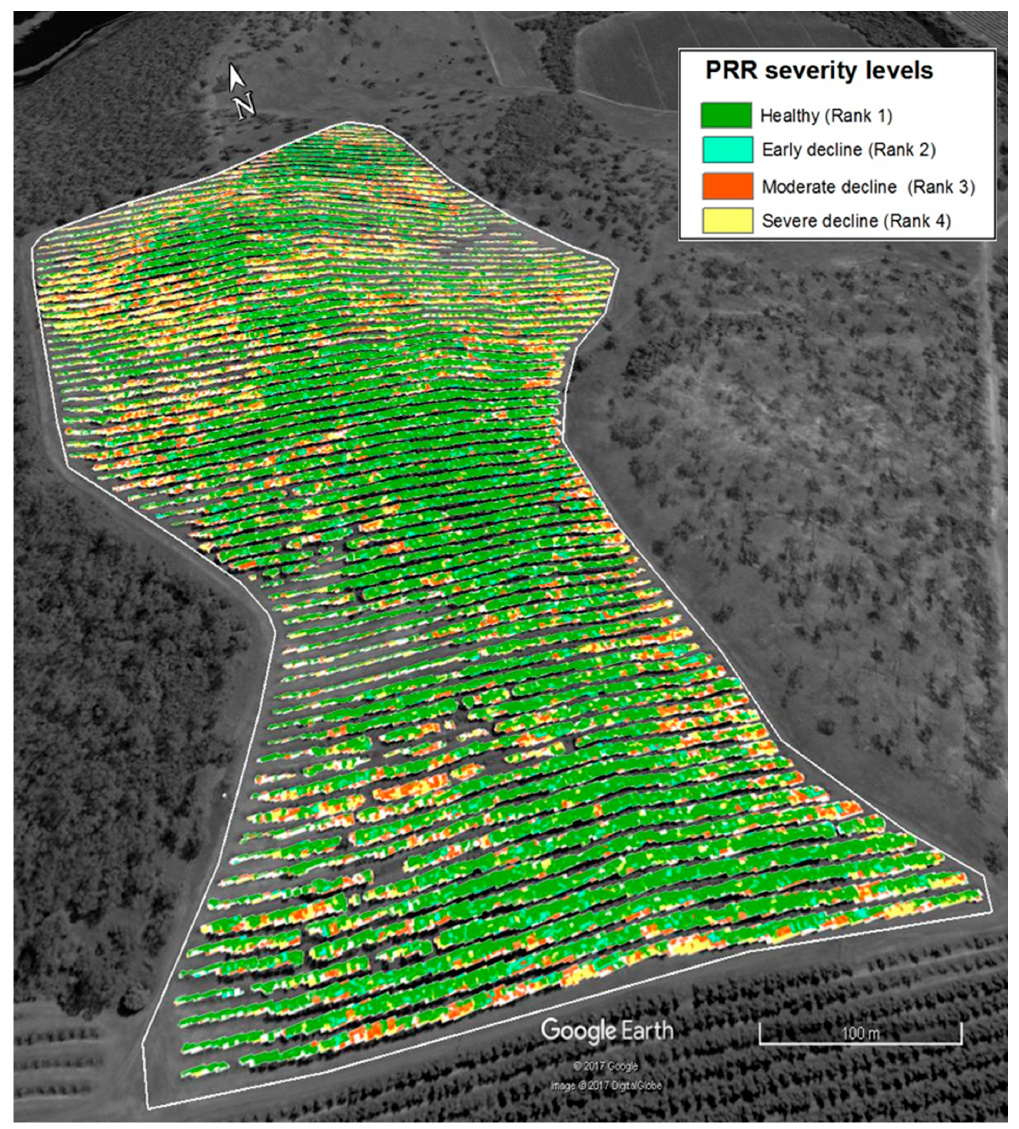
Figure 9. PRR severity distribution map of the avocado orchard classified according to SRVI and superimposed over an elevation layer.